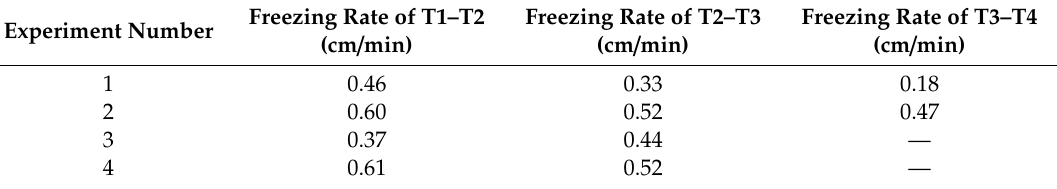
Figure 4. Comparison of temperature change at the T2 position in different conditions; ( a , b ) depict the influence of gas flow rate, ( c , d ) depict the influence of initial water content. Table 3. Freezing rate of each